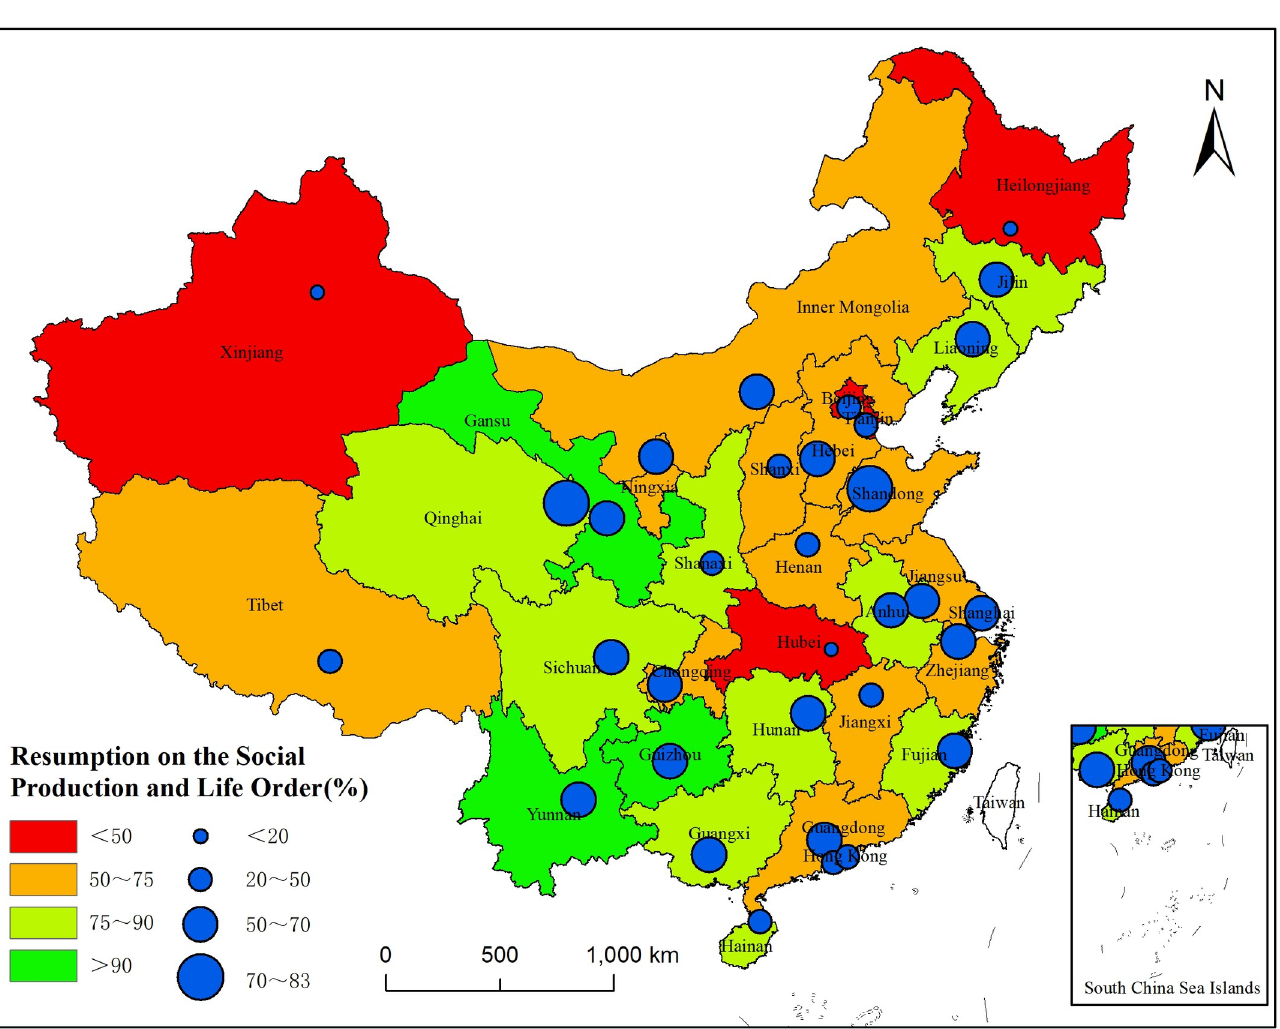
Fig 7. Distribution of the resumption of social production and